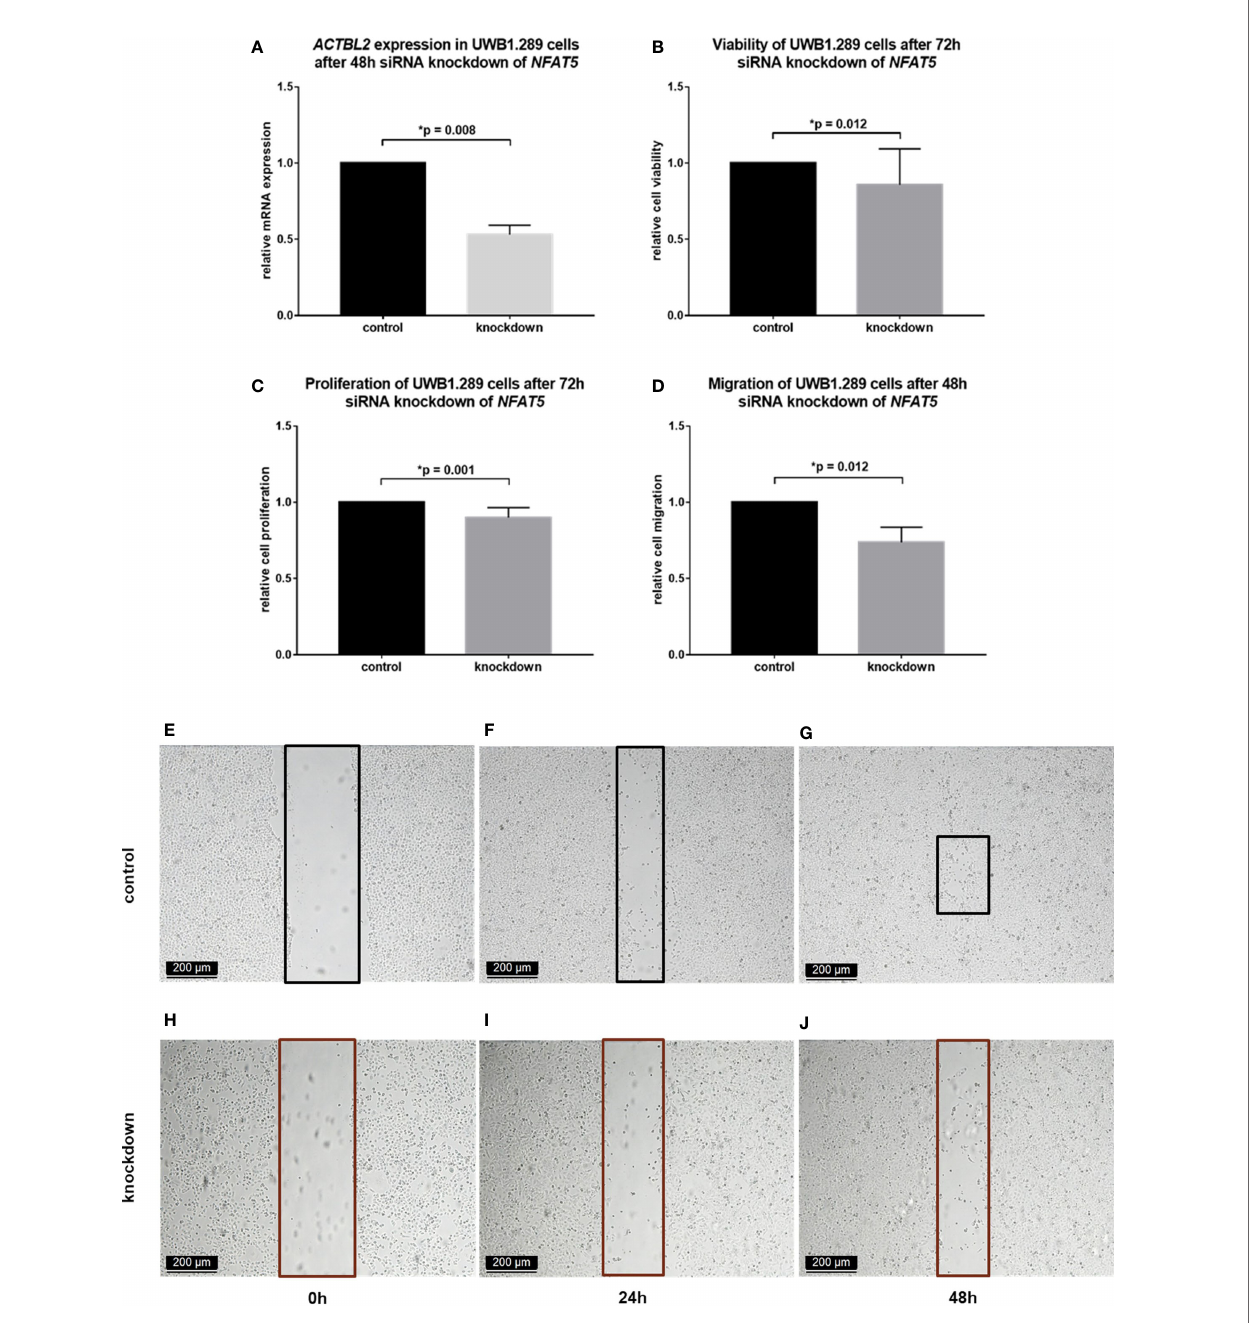
FIGURE 5 | Functional assays after NFAT5 silencing in UWB1.289 cells. (A) ACTBL2 expression in UWB1.290 cells after 48h siRNA (sequence 7) knockdown of NFAT5 , proving its successful downregulation on mRNA level compared to the untreated control ( p =0.008). (B) MTT assay results after siRNA knockdown of NFAT5 , showing a signi fi cantly reduced cell viability (n=8, p =0.012). (C) BrdU assay results, displaying a signi fi cantly decreased cell proliferation after silencing of NFAT5 (n=15, p =0.001) (D – J) Wound healing assay results (D) after siRNA knockdown of NFAT5 , showing a signi fi cantly reduced migration of UWB1.289 cells after 48h (H – J) compared to the untreated control ( E – G ; n=8, p =0.012) (10x magni fi cation; scale